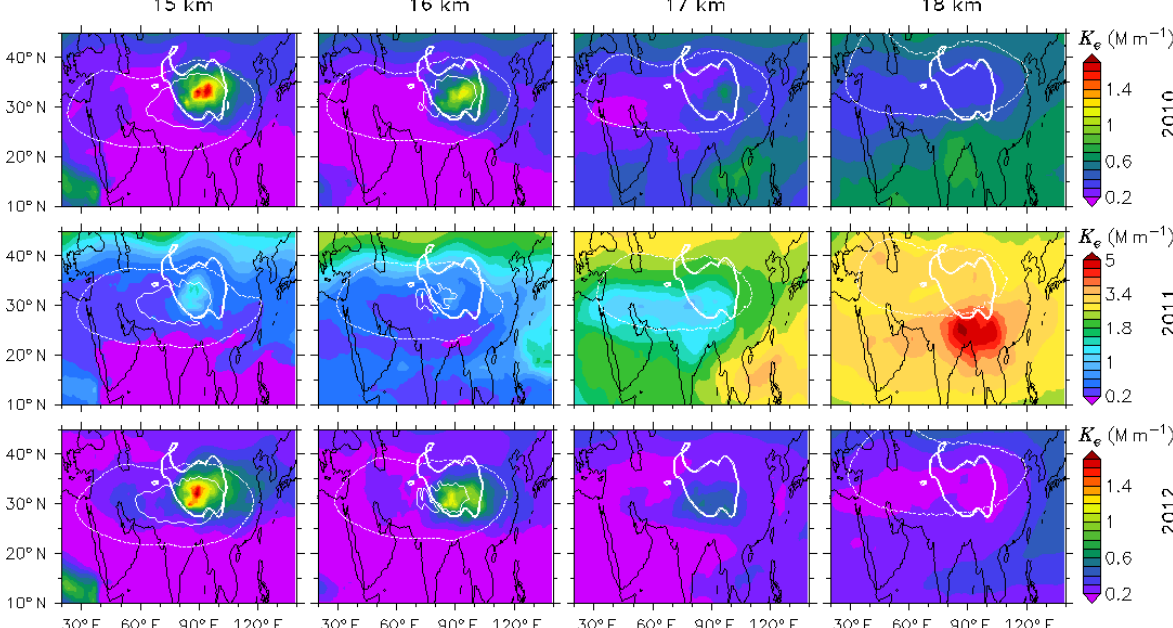
Figure 5. EMAC-simulated aerosol extinction coefficients at 550nm wavelength, K e , in units of Mm − 1 (i.e., 10 − 6 m − 1 ) at altitudes of 15, 16, 17, and 18kma.s.l. (first to fourth columns), averaged for July–August 2010 (top), 2011 (middle), and 2012 (bottom). Thin white lines indicate the anticyclone area, with the same index as used in Fig. 2. Thick white lines refer to the terrain height contour of 3km, highlighting the Tibetan Plateau area. Note that a different color bar scale is used for K e in 2011 from that in 2010 and 2012.